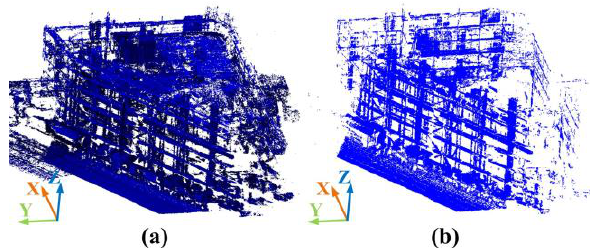
Figure 7. a) The original photogrammetric point cloud, b) the reduced point clouds after the statistical filtering and